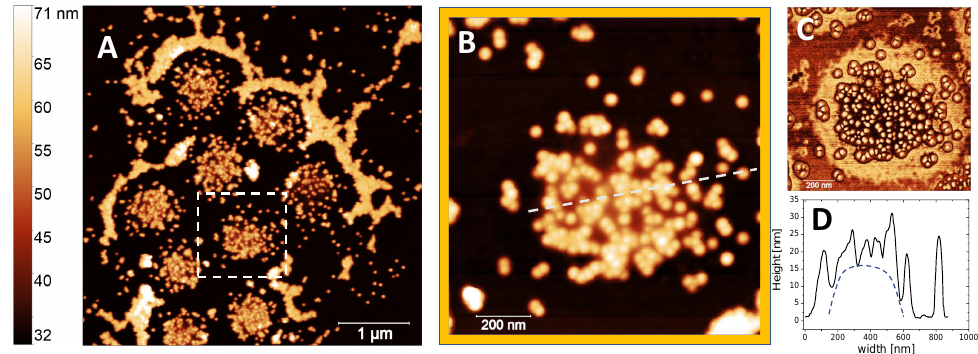
Figure 12. AFM images of NP-microgel complexes formed at T < T c at 0.1% NP weight fraction. Upon drying several NP-microgel complexes appear arranged in an ordered configuration sur- rounded by free and close-packed NP clusters (panel A ). Panel B shows a high magnification of the white-squared region in panel A . The phase image and the height profile of a single NP-microgel complex along the line shown in panel B are displayed in panels C and D respectively. In panel D , the dashed line following a spheroidal shape is a guide for eye,